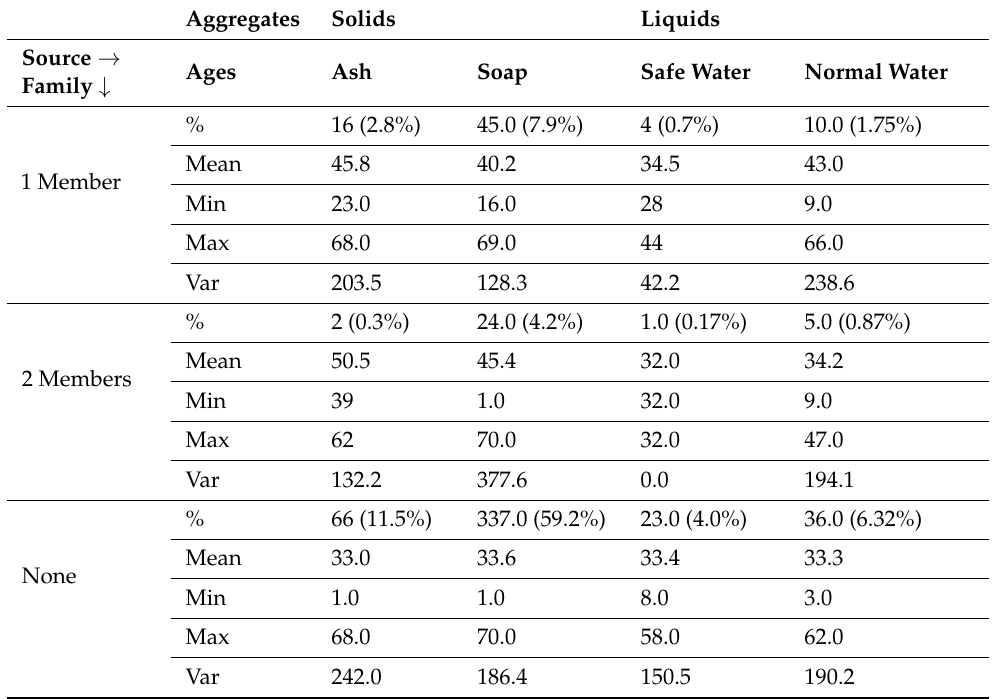
Table 8. Data classification on different sources (solid/liquid) used after toileting along with infected family